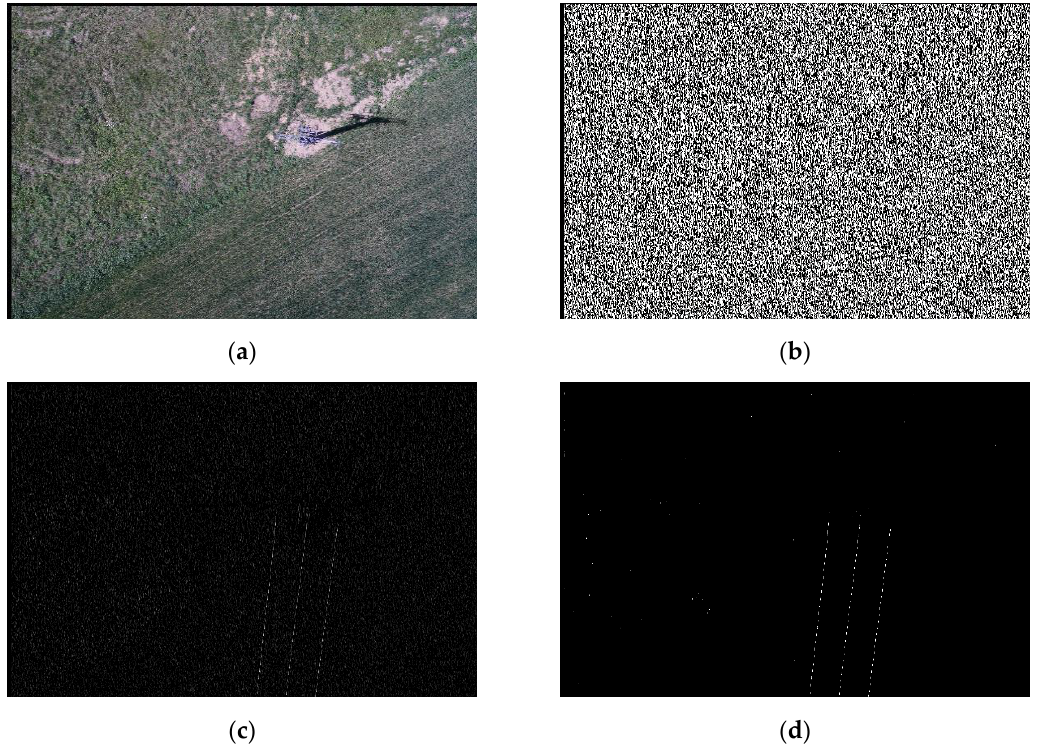
Figure 9. Four stages of image processing: ( a ) original image; ( b ) pre-processed image; ( c ) normalized image; ( d ) binarized image.